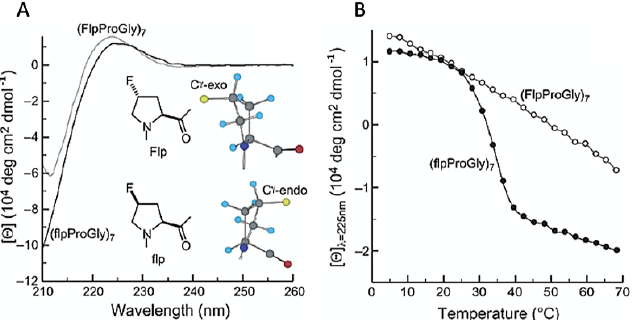
Figure 9. ( A ) Circular dichroism spectra at 5 ◦ C. Inset: Structures of flp and Flp. ( B ) Thermal denaturation curves determined by measuring molar ellipticity at 225 nm as a function of temperature ( ± 1 ◦ C). Reprinted with permission from [63]. Copyright 2003, American Chemical